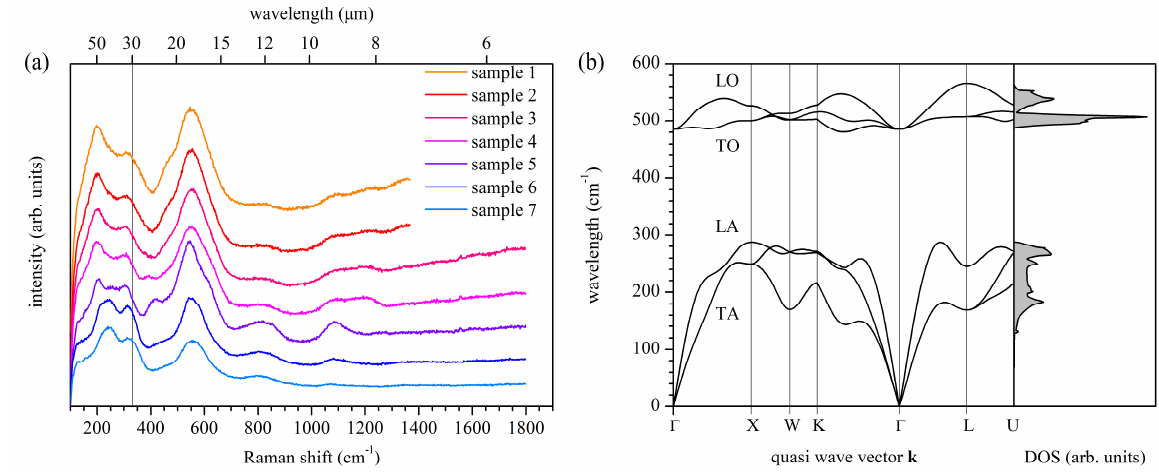
Figure 4. ( a ) Experimental Raman spectra of all samples and ( b ) phonon band structure with a corresponding density of states.